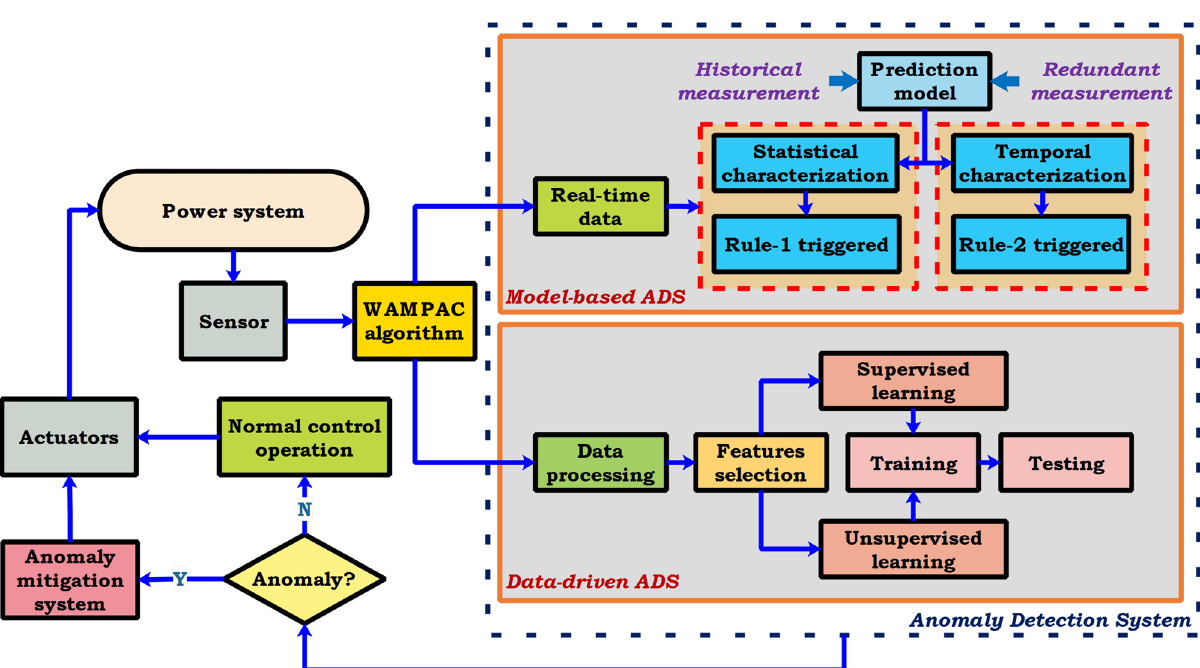
Figure 13. Attack-resilient system architecture for